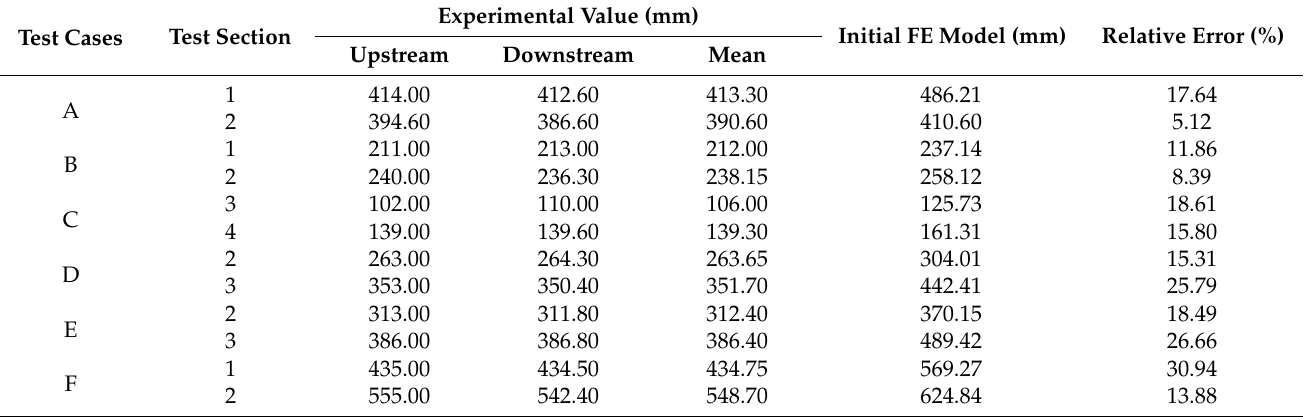
Table 5. Calculated value and test value of displacement of each measuring point under each load